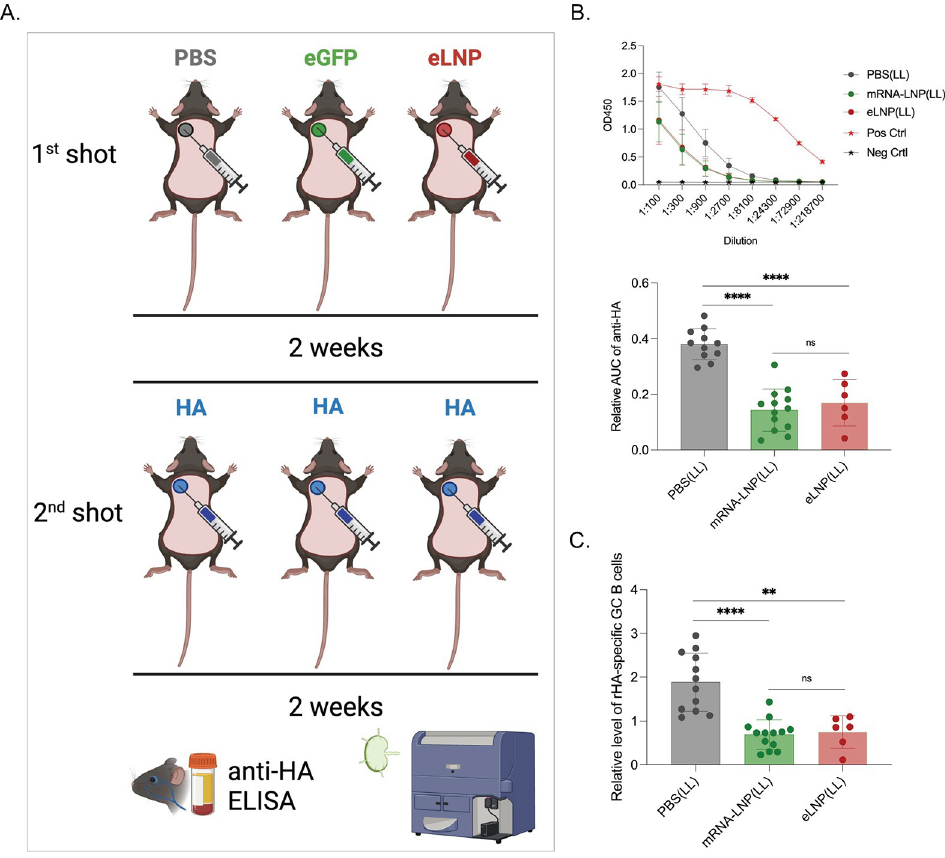
Fig 1. Pre-exposure to mRNA-LNPs or LNPs significantly inhibits subsequent adaptive immune responses induced by the mRNA-LNP vaccine. A ). Experimental model. Animals were shaved and intradermally inoculated in the left upper spot with either PBS, mRNA-LNP coding for eGFP (eGFP) or empty LNP (eLNP). Two weeks later the same areas were injected with PR8 HA mRNA-LNP (HA). Serum and skin draining lymph nodes were harvested 2 weeks later and the anti-HA serum antibody levels determined using ELISA and the germinal center (GC) B cell responses using flow cytometer (please see Materials and Methods for details on data normalization). B ). Serum anti-HA antibody levels detected by ELISA. OD450 readings (top) at different serum dilutions. Summary graph of the relative area under the curve (AUC) for each sample (middle). C ). GC B cell responses (CD38 - GL7 + ) from the same mice. Each dot represents a separate mouse. Data from at least two separate experiments pooled and are shown as mean ± SD. One-way ANOVA was used to establish significance. ns = not significant. �� p < 0.005, ��� p < 0.0005, ���� p < 0.0001. Figures were drawn by the authors using